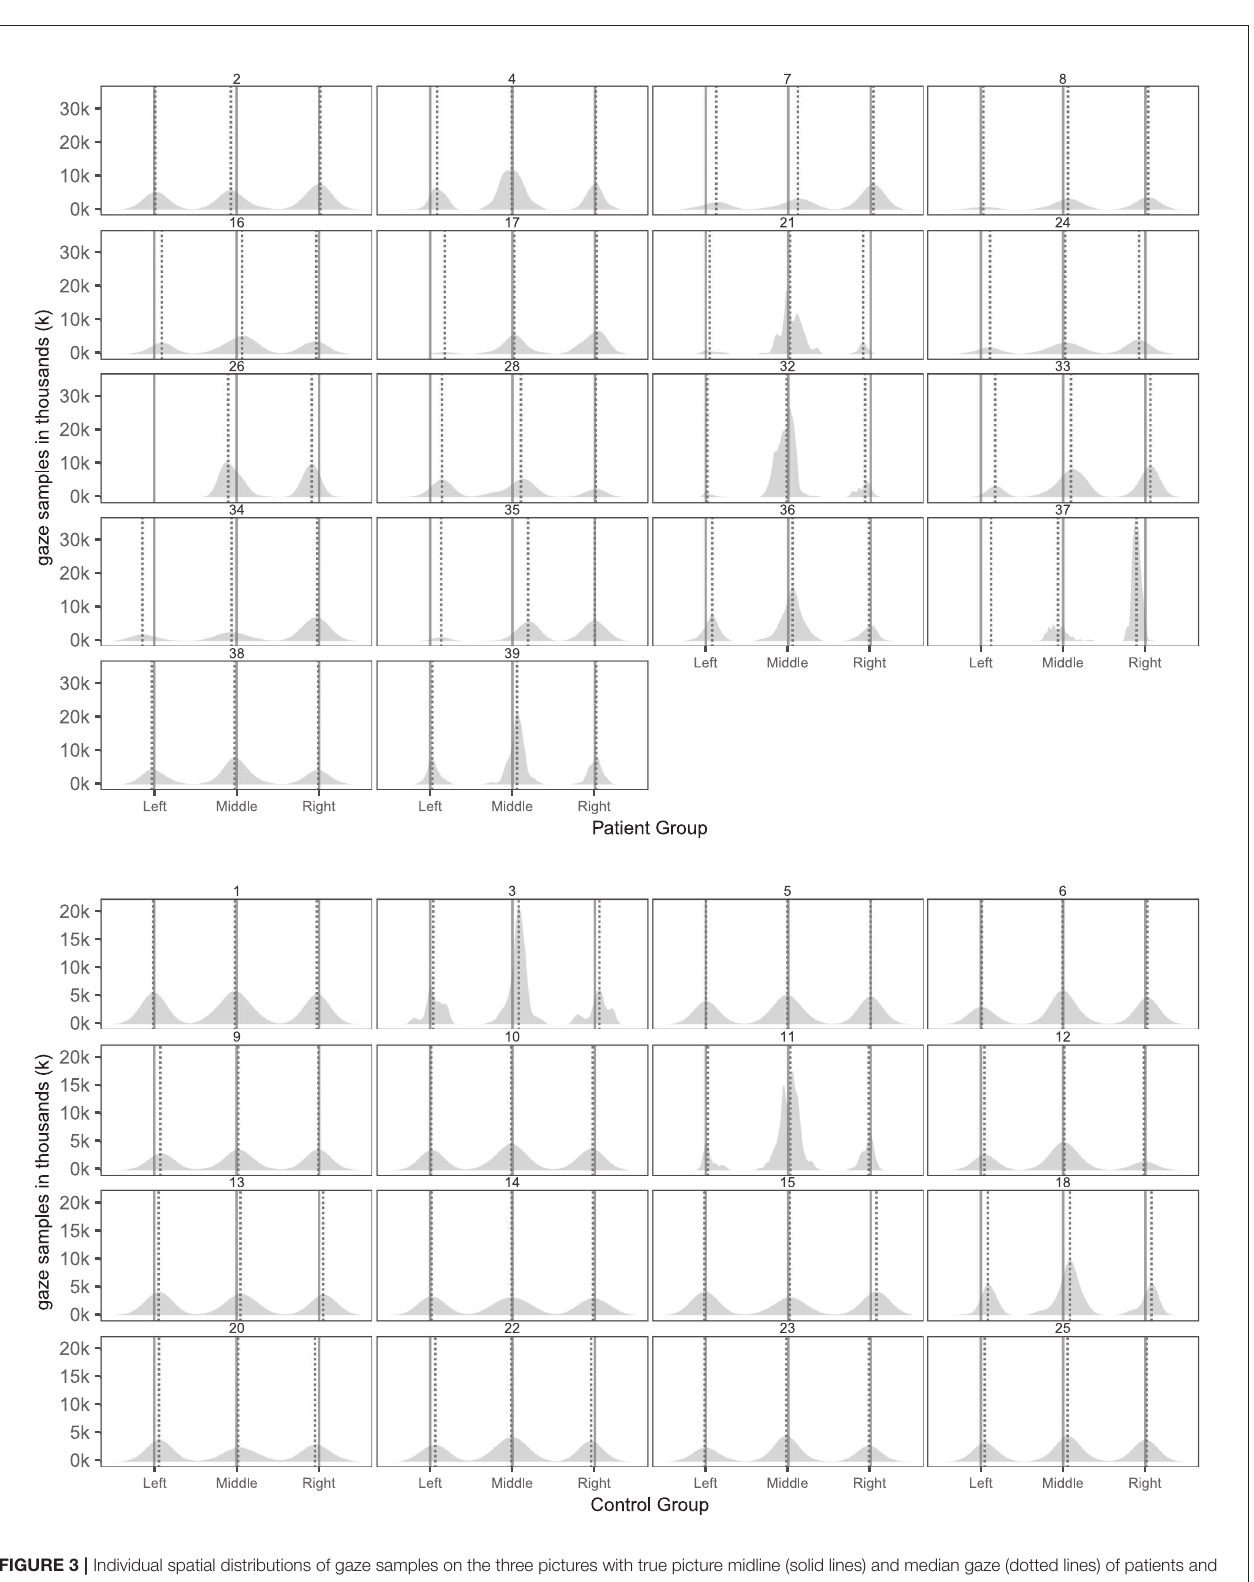
Frontiers in Psychology |